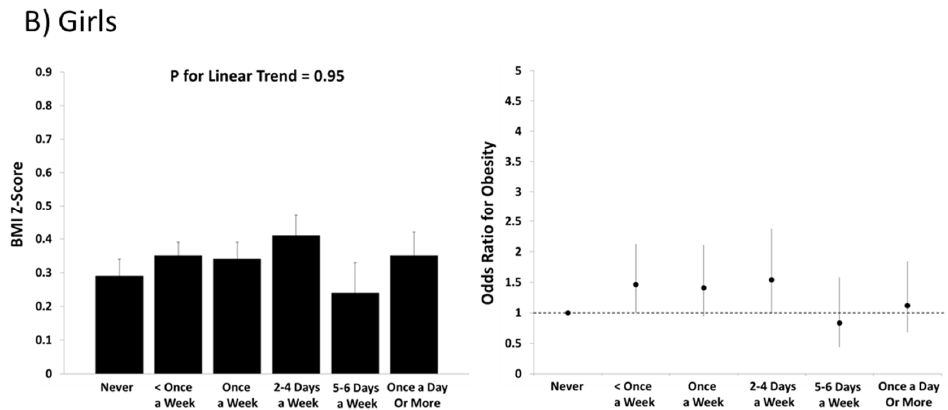
Figure 1. BMI z ‐ scores and odds ratios for obesity across levels of consumption of regular soft drinks in ( A ) boys and ( B ) girls in the International Study of Childhood Obesity, Lifestyle and the Environment (ISCOLE). BMI z ‐ scores were computed from World Health Organization reference data and associated error bars represent standard errors. Obesity was defined at >+2 standard deviations using World Health Organization reference data and associated error bars represent 95% confidence intervals. All models included age, study site, highest parental education and meeting physical activity guidelines as covariates.